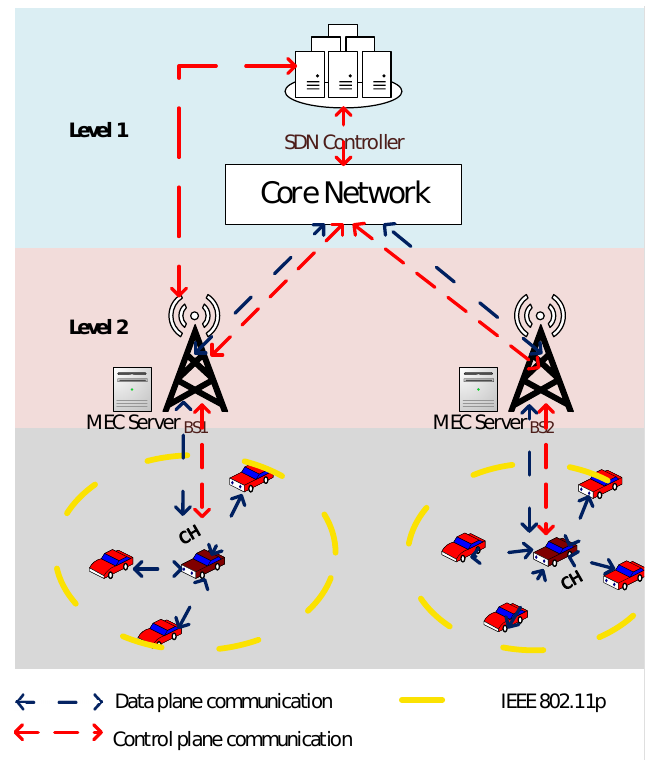
Figure 1. Software defined networking (SDN) enabled 802.11p/cellular hybrid Vehicular Ad hoc NETwork (VANET)